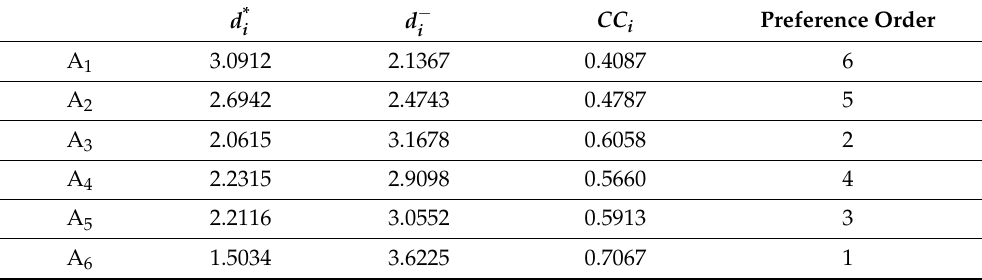
Table 10. Distances from fuzzy +/ − solutions, the distance coefficients and the preference